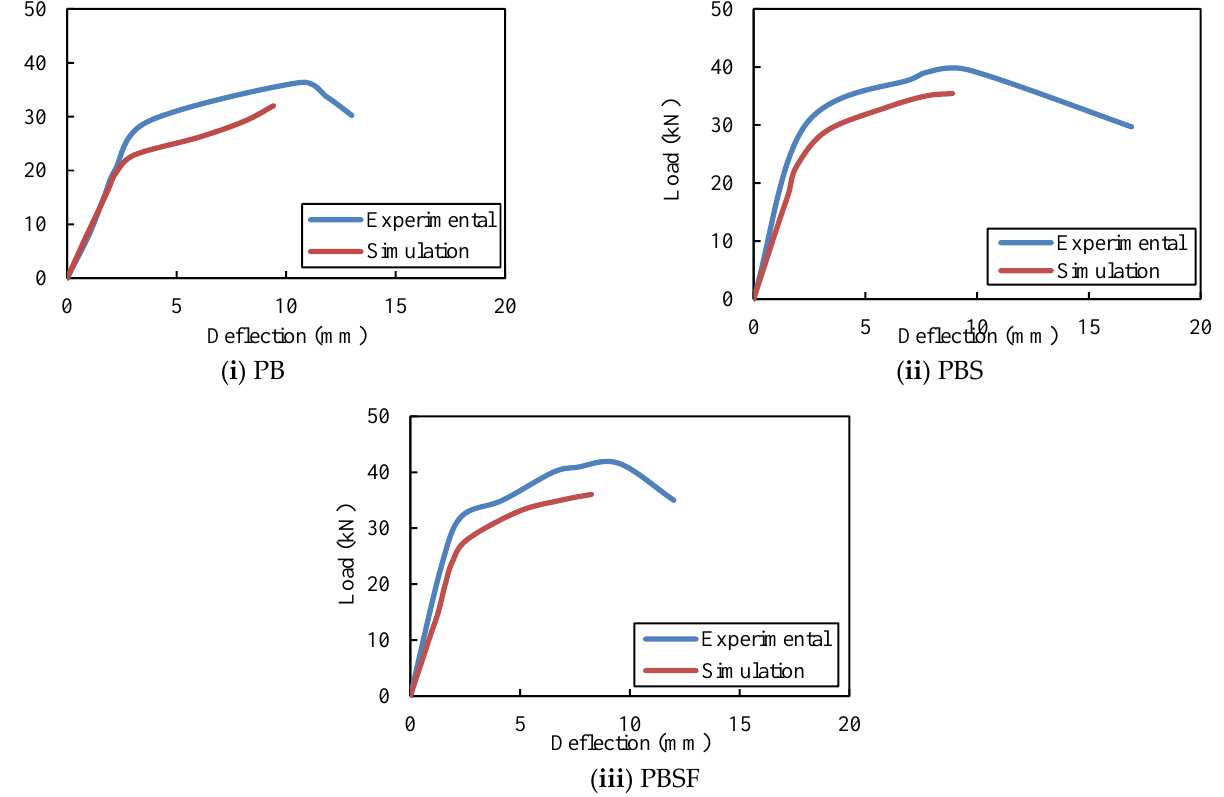
Figure 22. ANSYS and experimental deflections of the CFS beams.